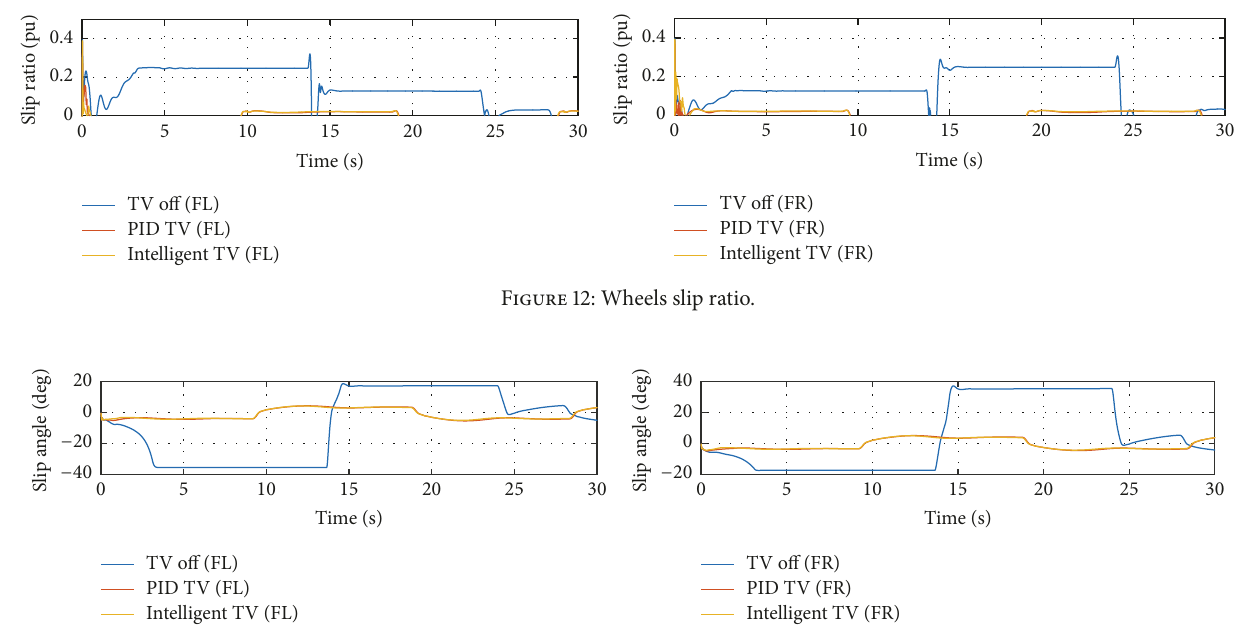
Figure 13: Wheels slip